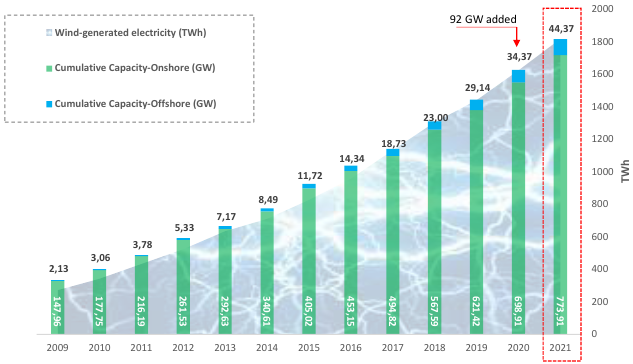
Figure 1. Accumulated and generated wind-energy evolution. Own